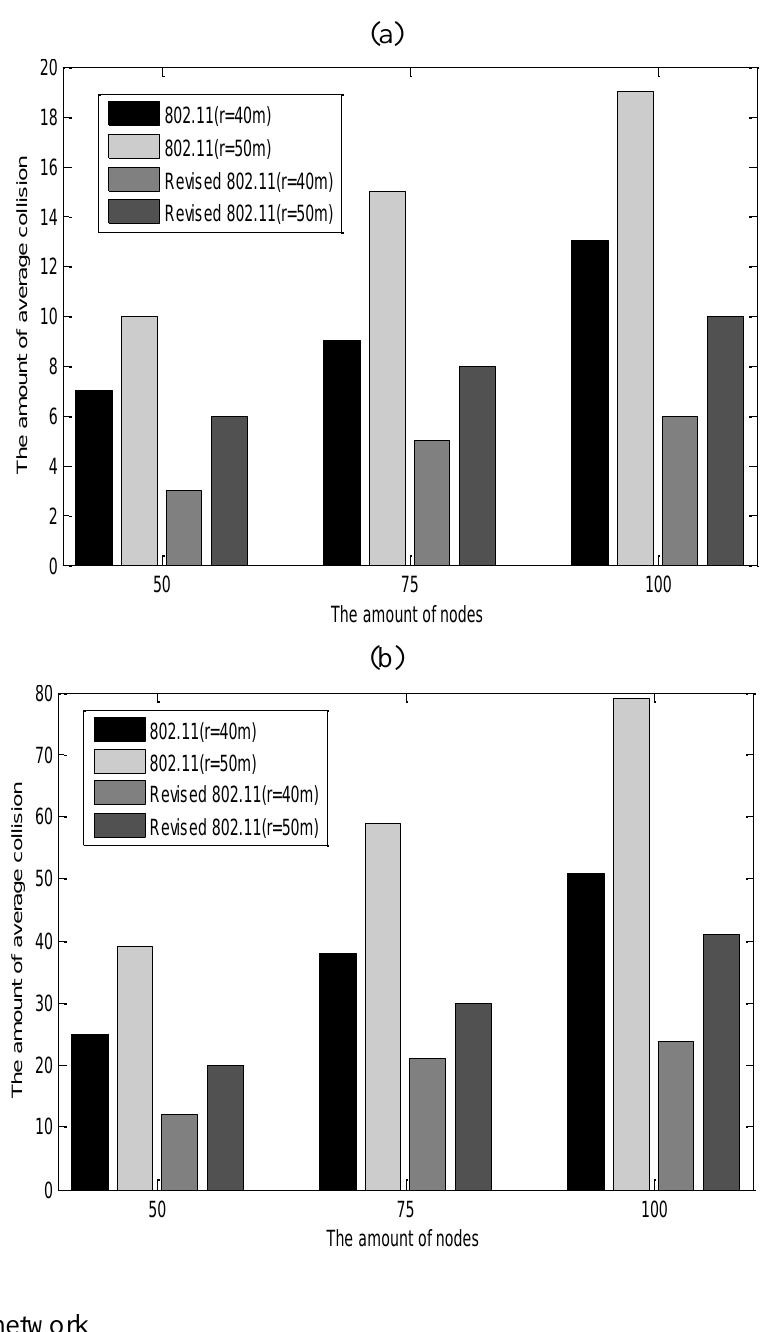
Figure 15. (a) The minimal AAC in the network; (b) The maximal AAC in the